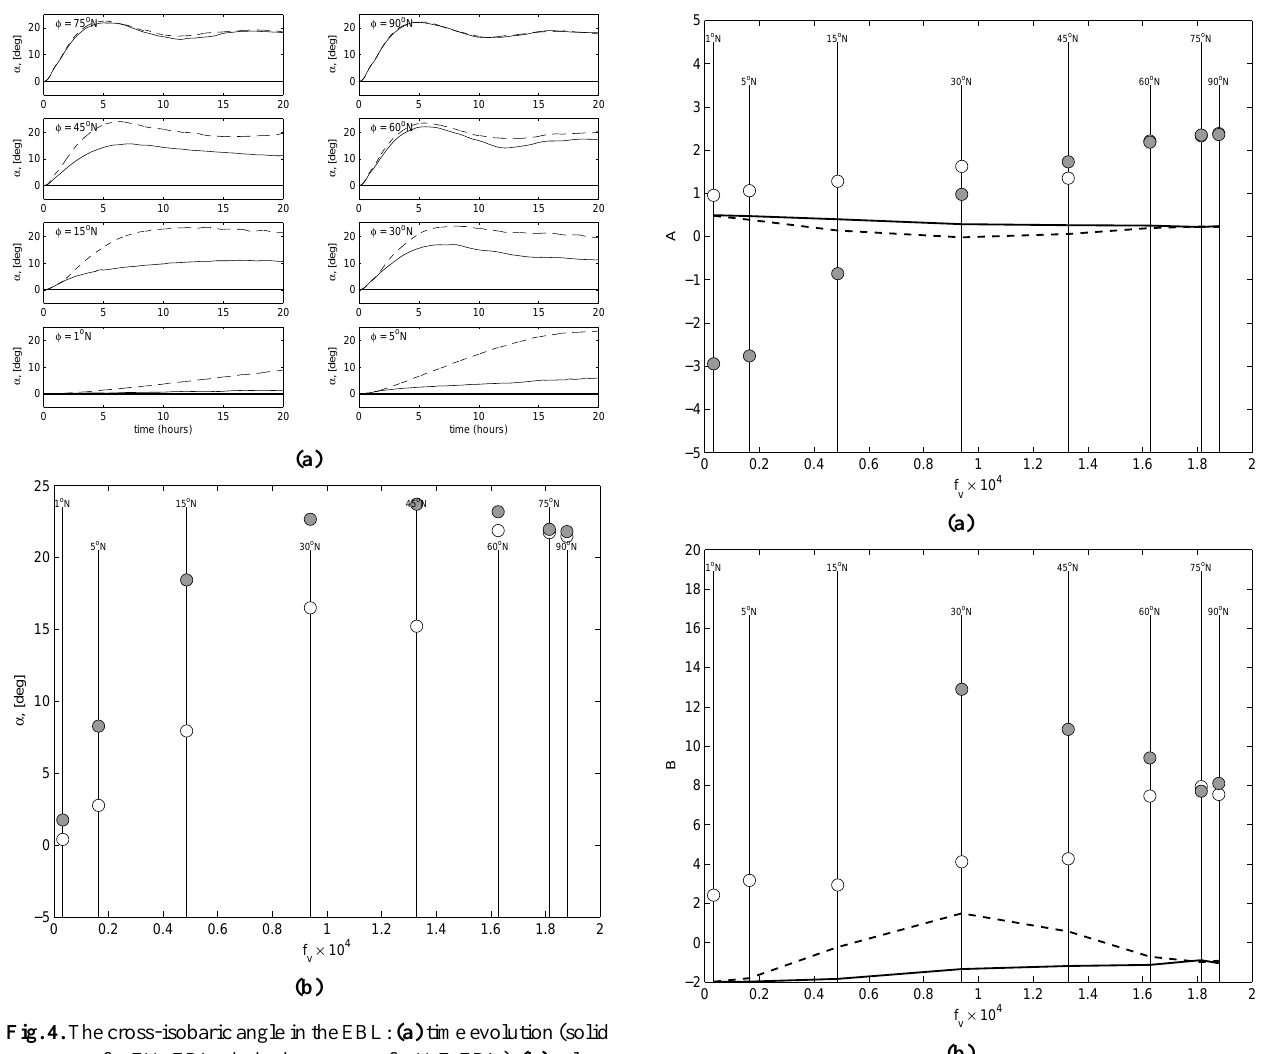
Fig. 4. The cross-isobaric angle in the EBL: (a) time evolution (solid curves are for EW-EBL; dashed curves are for WE-EBL); (b) values of α at hour six of the LES integration. Shaded circles show the WE-EBL; open circles, the EW-EBL.